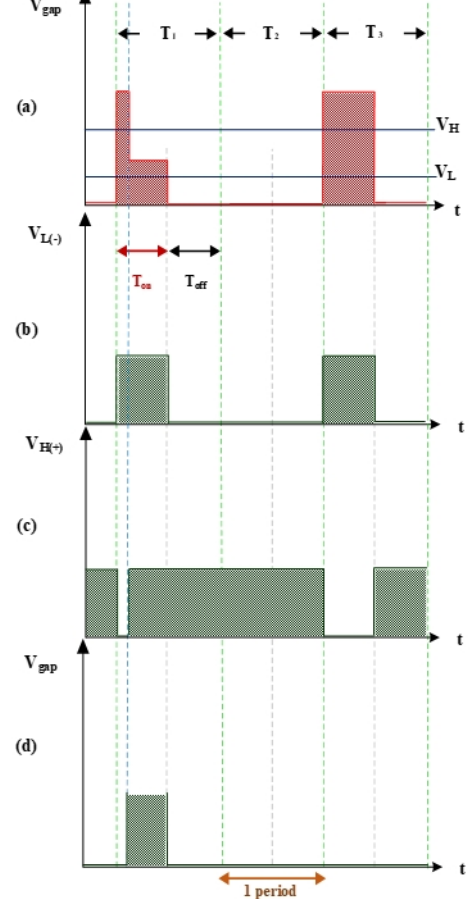
Figure 3. Voltage waveforms: ( a ) V gap , V H , and V L ; ( b ) V L input into the comparator; ( c ) V H input into the comparator; and ( d ) gap electrical discharge.